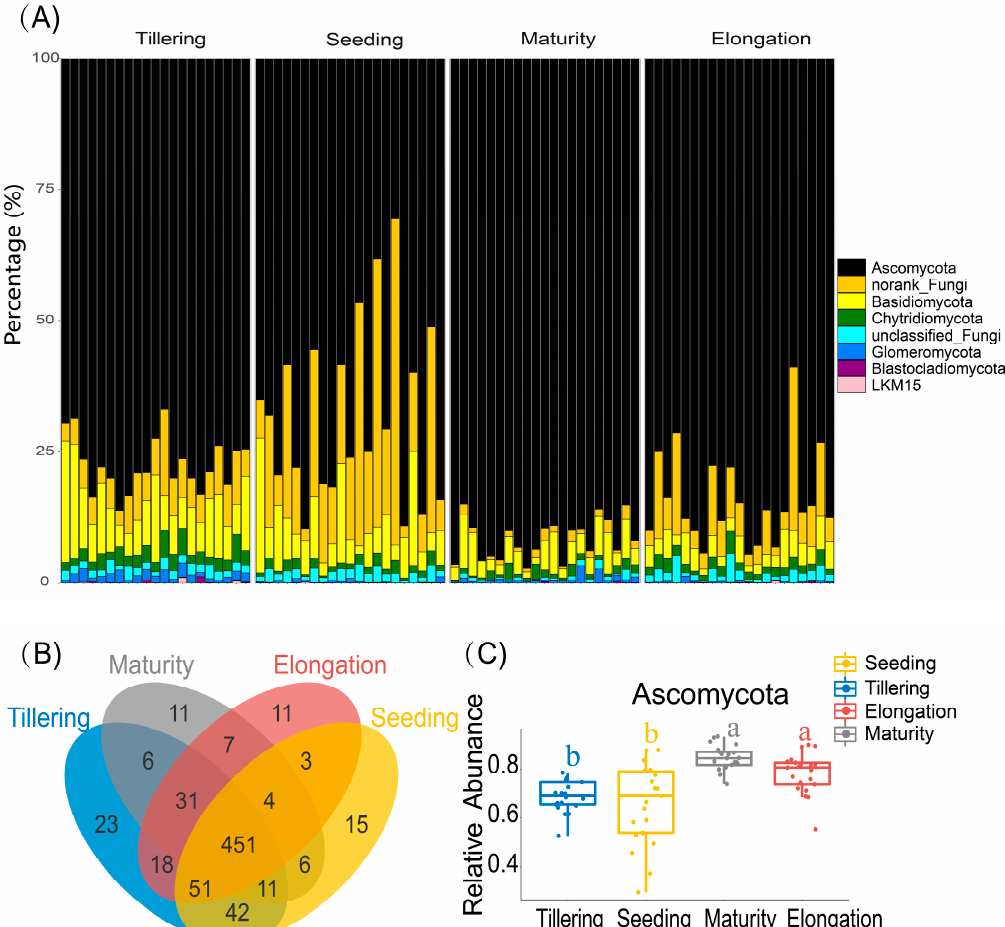
Figure 3. Different stages influence the diversity profiles of the rhizosphere soil microbiota. ( A ) The histogram showed that relative abundances of the main phyla according to four different growth periods were determined from twenty-one soil samples of each period. ( B ) A Venn diagram of operational taxonomic units (OTUs) among four stages (Seeding, Tillering, Elongation, Maturity). ( C ) The boxplot of the relative abundance of Ascomycota, the rhizosphere fungus of sugarcane, in di ff erent stages (FDR adjusted p < 0.05).